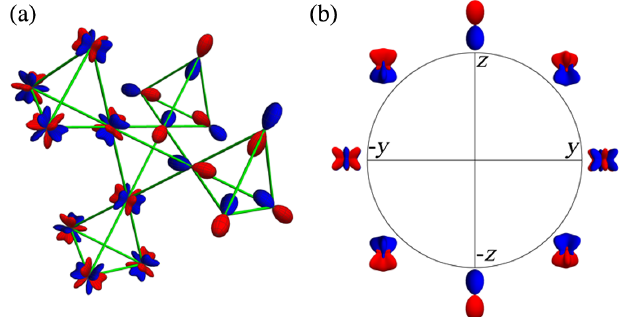
FIG. 1. (a) The magnetic charge distributions associated with octupoles (left) and dipoles (right) are depicted at the vertices of five corner-sharing tetrahedra, making up part of the pyrochlore lattice. (b) Octupolar and dipolar components inhabit the same Ce 3 þ pseudospin- 1 = 2 degrees of freedom in Ce 2 Zr 2 O 7 , such that y components behave as octupoles, while the x and z components of each pseudospin- 1 = 2 behave as dipoles, as schematically illustrated here using the magnetic charge distributions associated with different directions of pseudospin in the yz